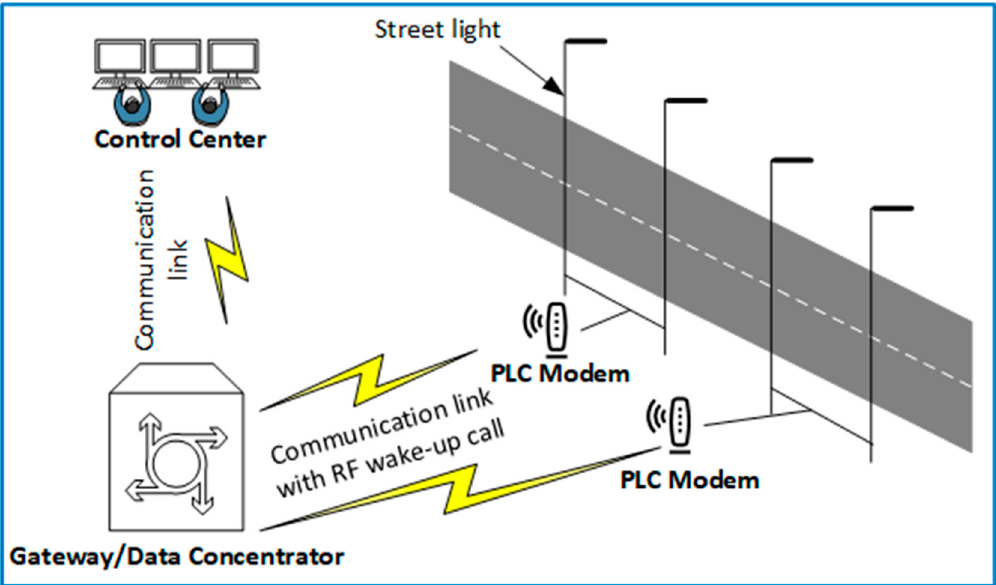
Figure 10. Description of Passive wake-up radio for smart grid application.